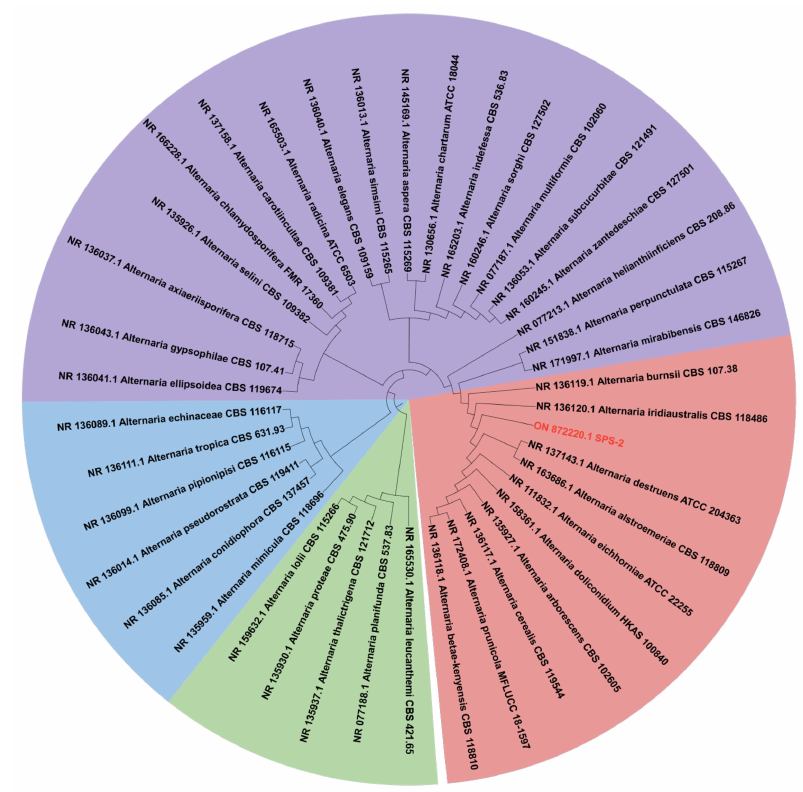
Figure 2. ITS-based phylogenetic tree of strain SPS-2 marked in